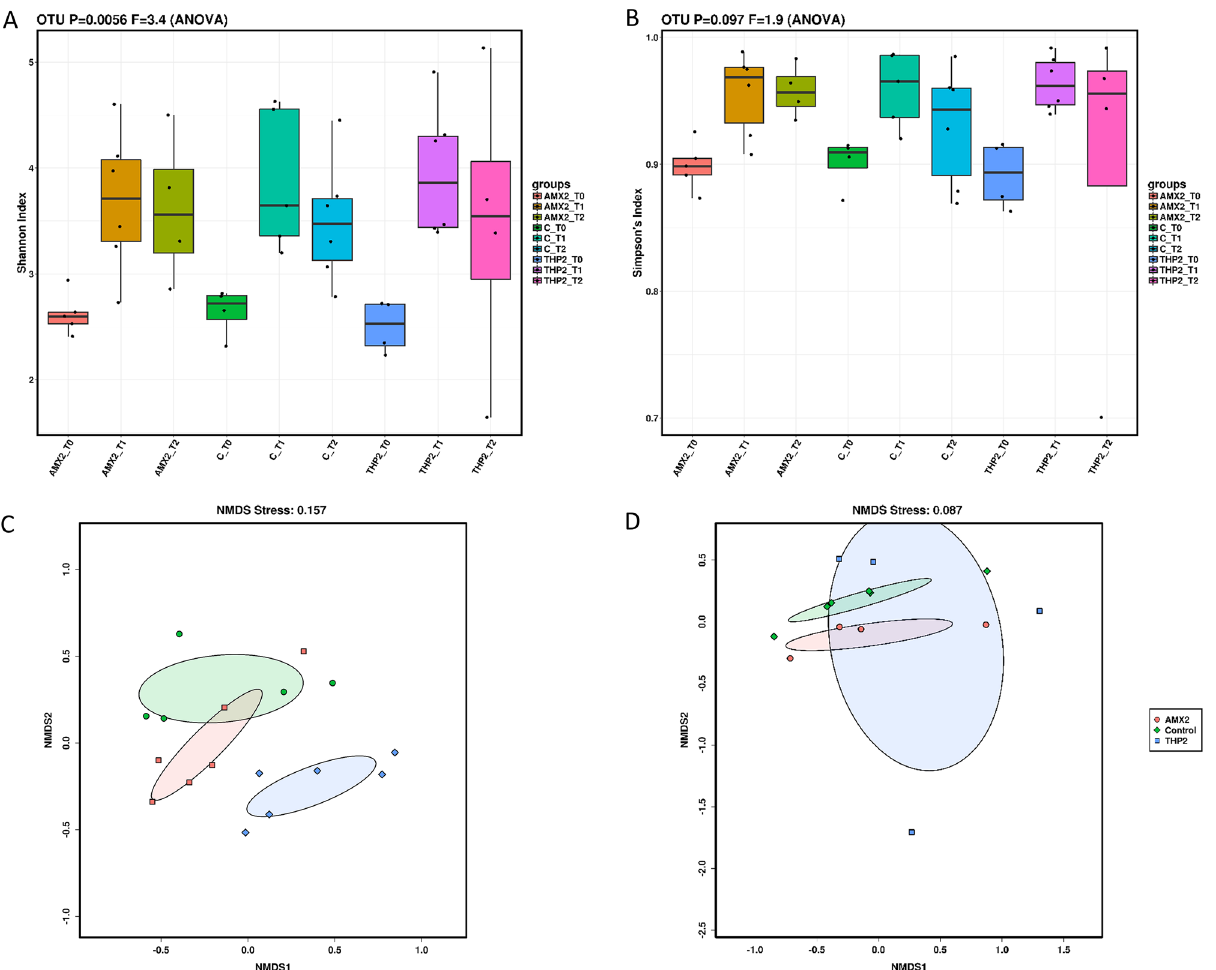
Figure 3. α-Diversity within groups treated at middle-age at different time points using Shannon ( A ) and Simpson ( B ) indexes. Boxplots represent 25th to 75th percentiles and whiskers showing a maximum of ×1.5 the interquartile range (IQR). β-Diversity between treatment groups on day 1 p.t. ( C ) and day 9 p.t. ( D ). Samples are clustered according to Bray Curtis